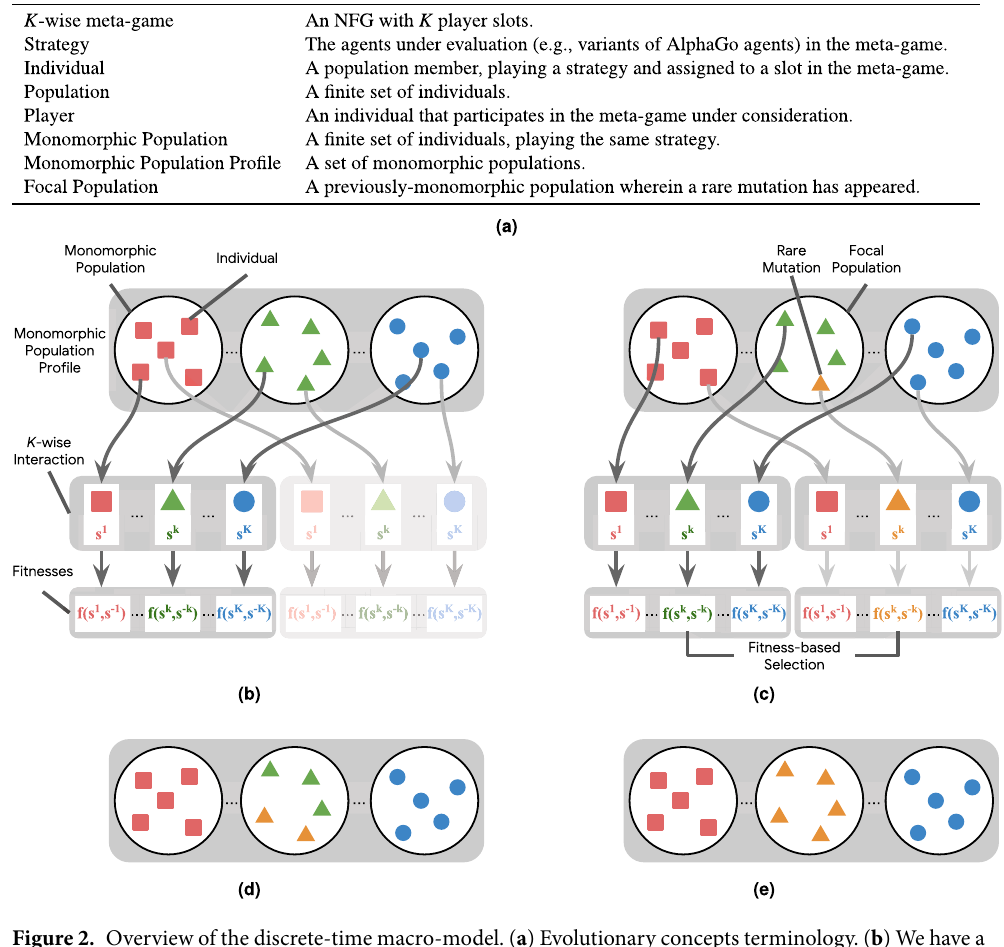
deviate from its current strategy.